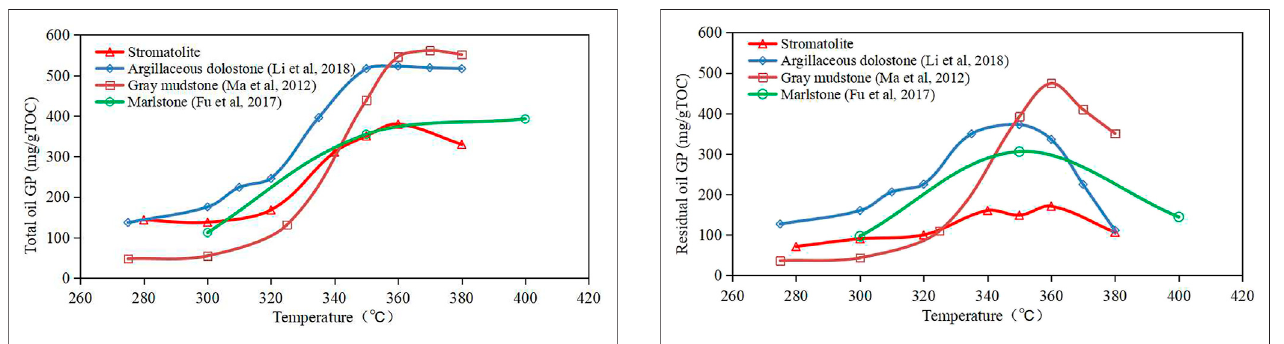
FIGURE 6 | Comparison of total oil generation potential. FIGURE 7 | Comparison of residual oil generation potential.